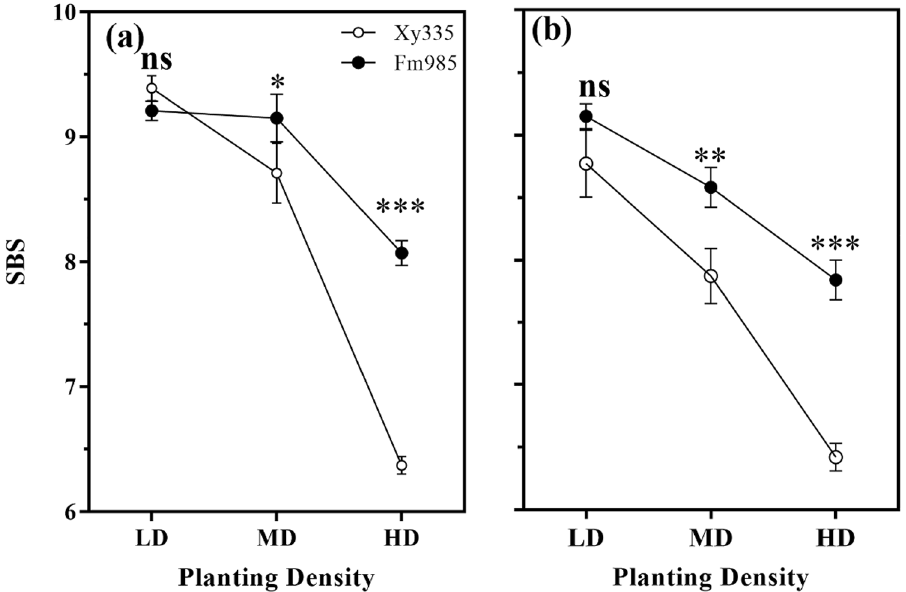
Figure 2. Stalk bending strength (SBS) under different treatments in 2018 ( a ) and 2019 ( b ); SBS were estimated by horizontal pulling resistance value; bars denote the SE of the mean (n = 5); *, ** and ***indicate differences significant at 0.05, 0.01 and 0.001 level; ns indicates no significant ( P > 0.05).